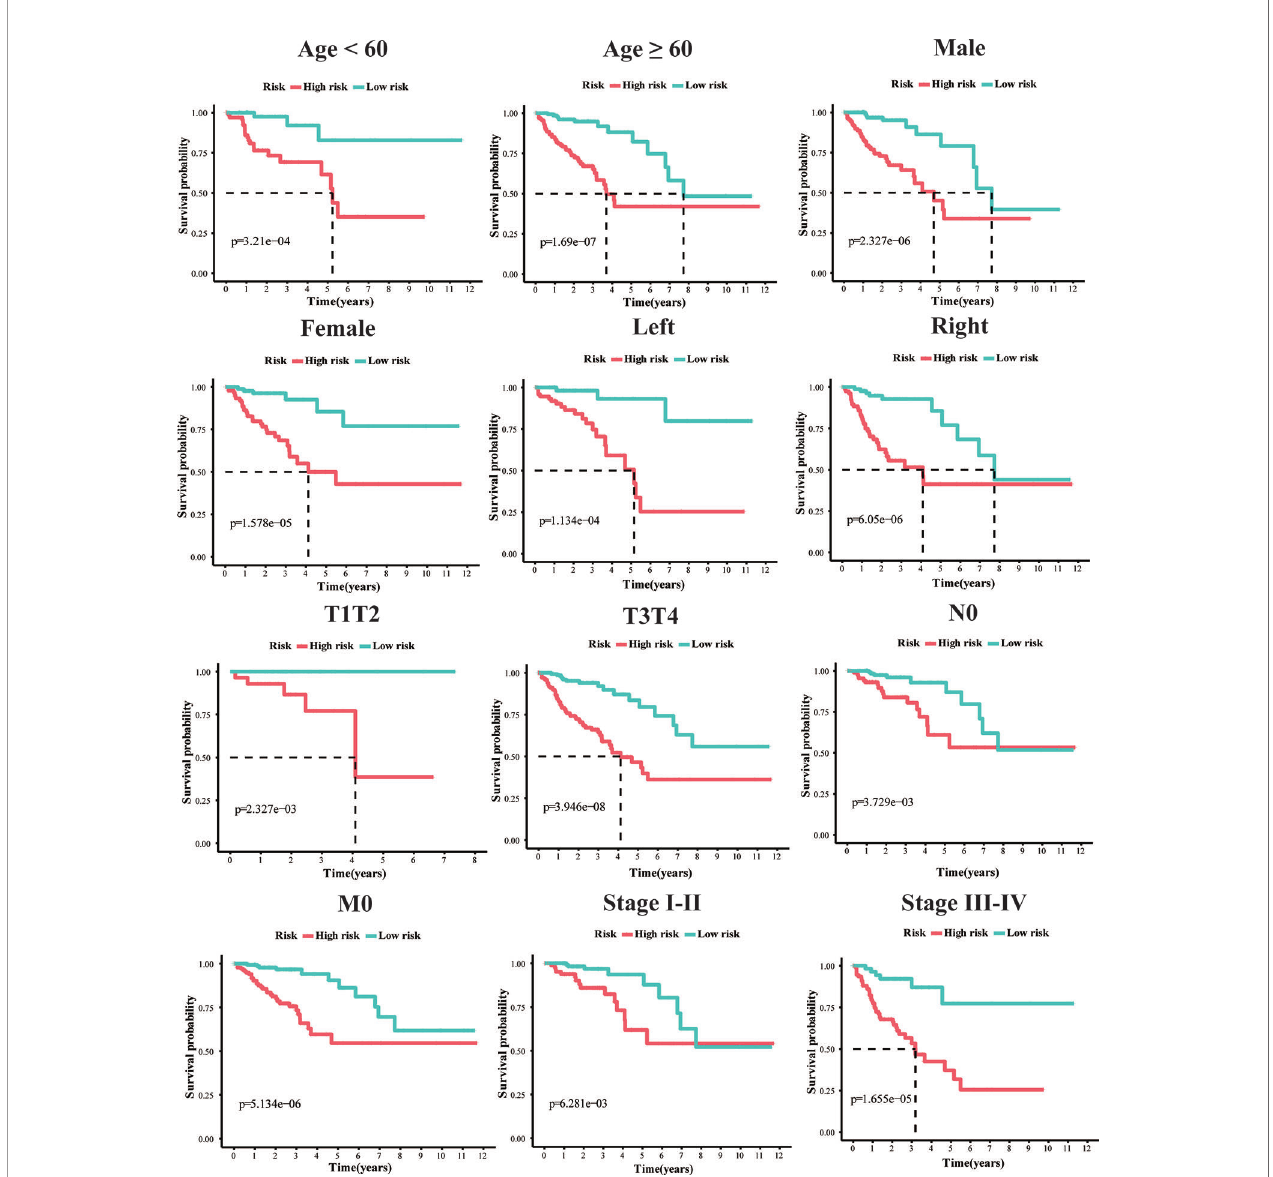
FIGURE 4 | Kaplan – Meier survival plots of the 10 gene signature in TCGA dataset with different clinical characteristics (Age, Gender, T1+T2, T3+T4, N0, M0, stage I+II, stage III+IV, Left-hemi CRC and Right-hemi